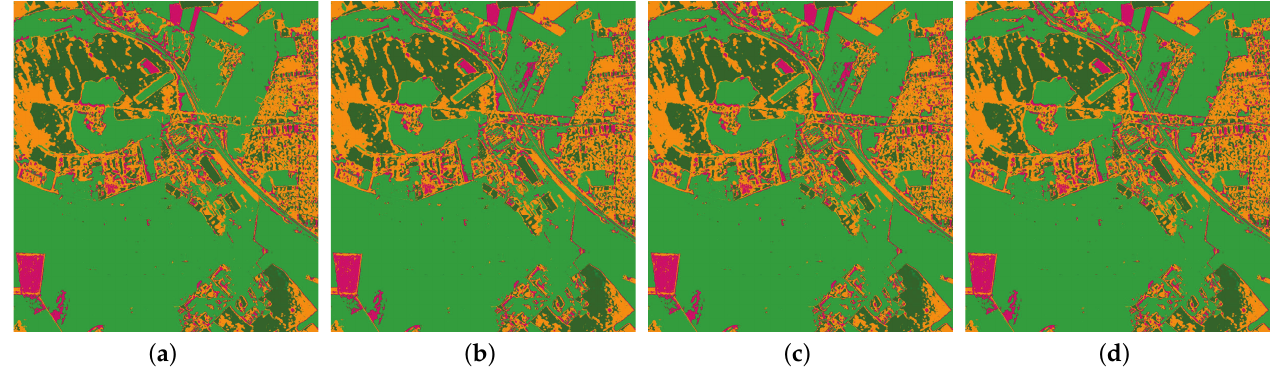
Figure A4. Classification results with different adjacent parameters. ( a ) Result with adjacent parame- ter 0.25. ( b ) Result with adjacent parameter 0.5. ( c ) Result with adjacent parameter 0.75. ( d ) Result with adjacent parameter